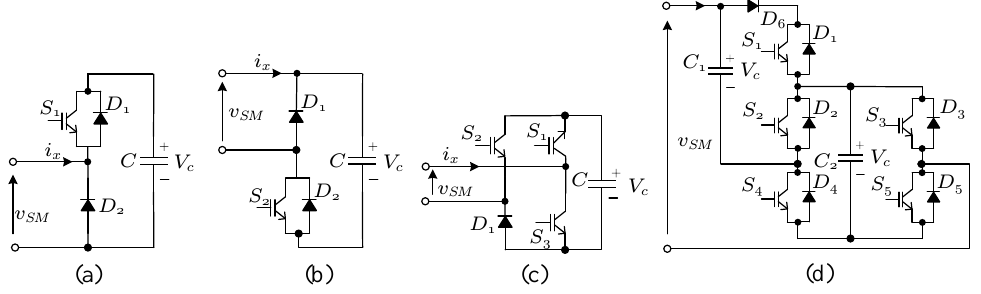
Figure 10. Unidirectional SMs: ( a ) Unidirectional SM1; ( b ) Unidirectional SM2; ( c ) RD-SM—Reduced device SM; and ( d ) CHBFBSM—Combined half-bridge full-bridge